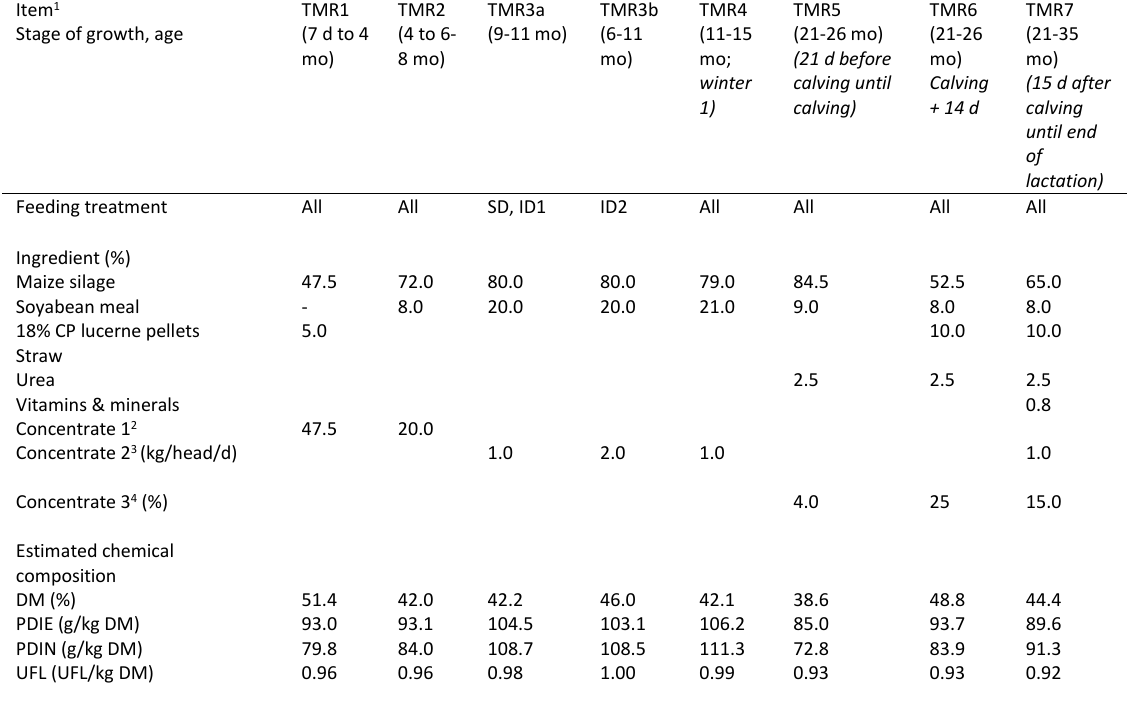
Table 1. Ingredients and chemical composition of the experimental